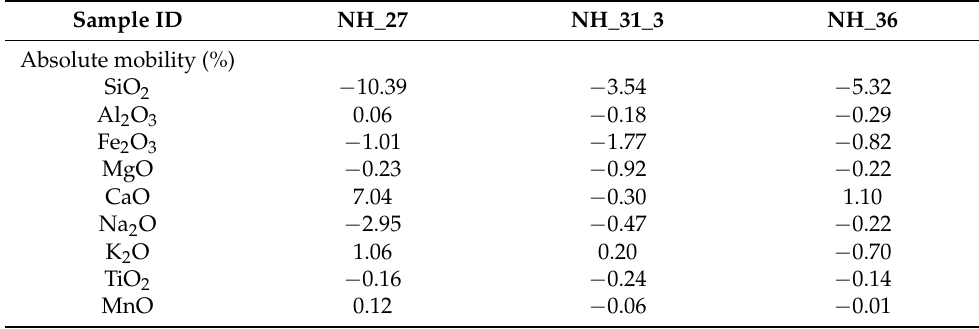
Table 5. Results of mass-balance calculations assuming Fv = 1.